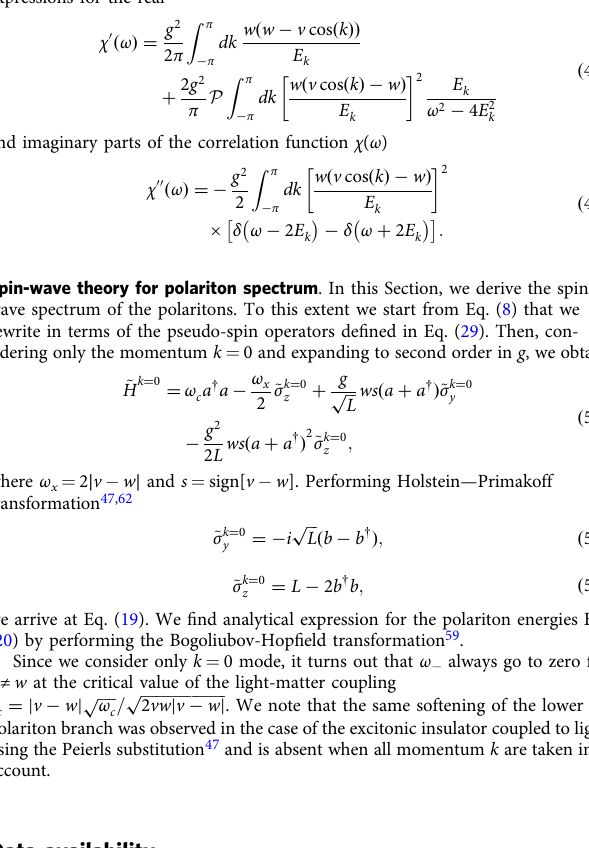
. We note that the same softening of the